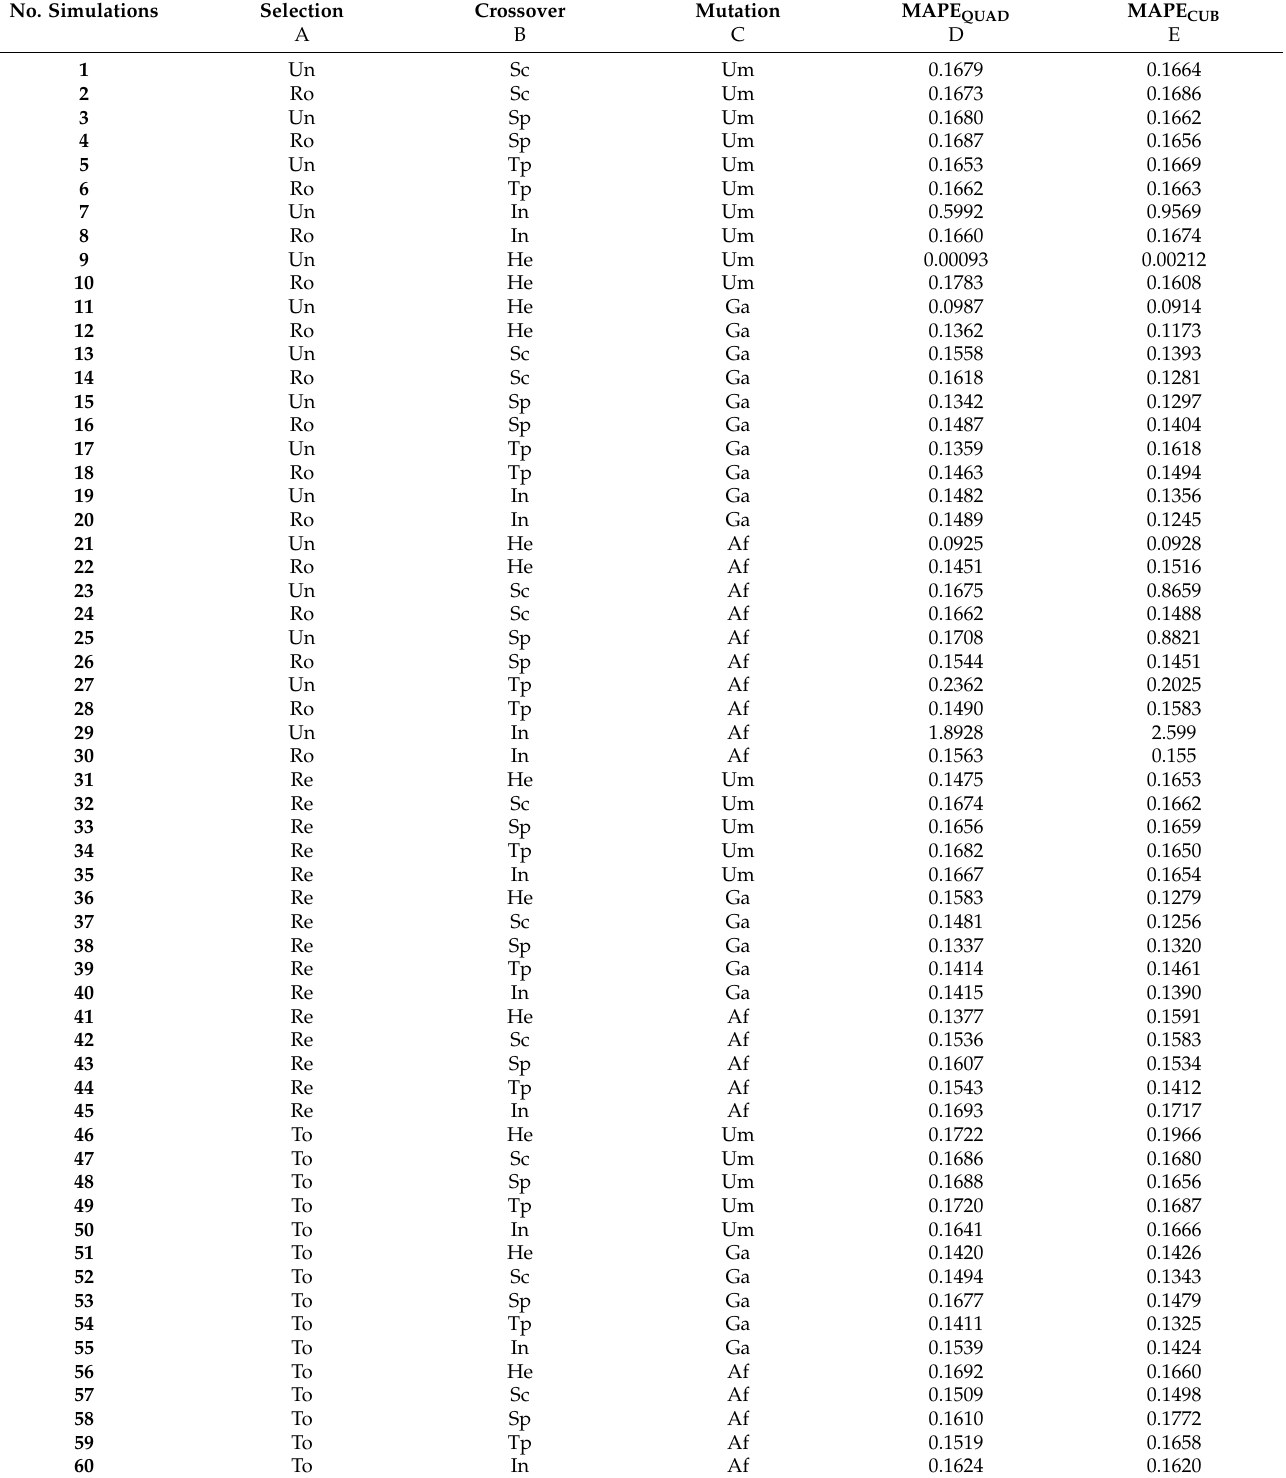
Table 5. The results of errors for the two